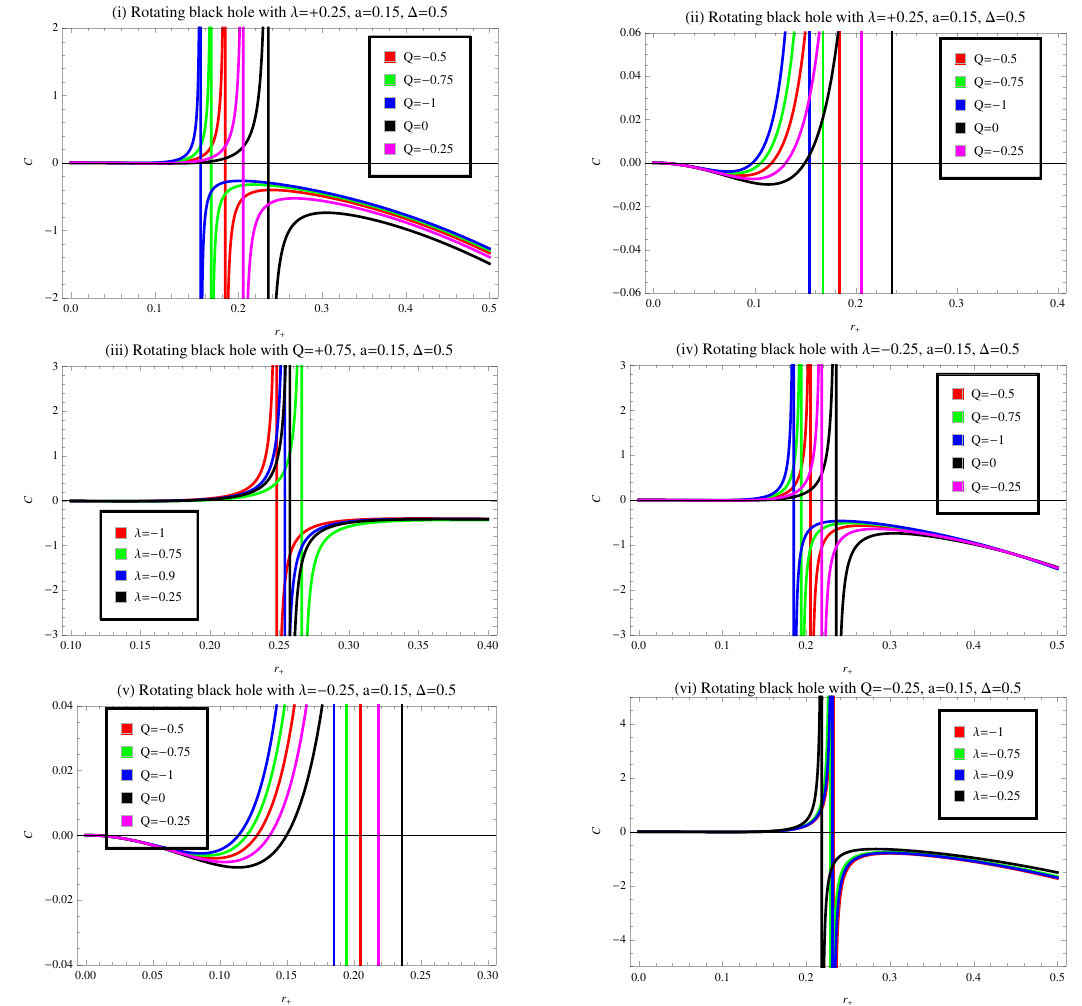
H i L Rotatingblack holewith Λ=+ 0.25, a = 0.15, D= 0.5